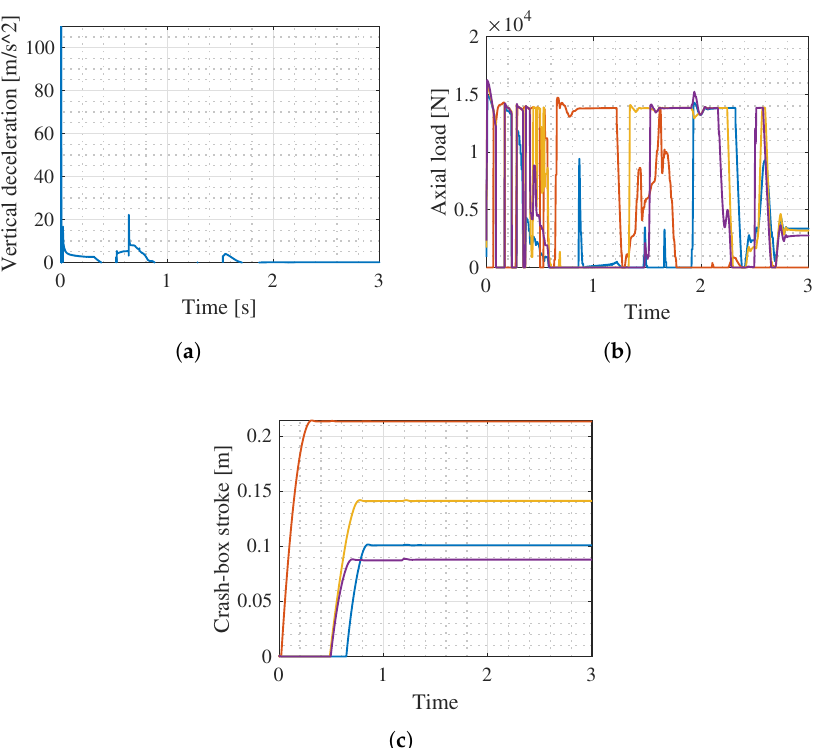
Figure 13. Landing multi-body simulation results for leg 1 (orange), leg 2 (yellow), leg 3 (blue) and leg 4 (violet) according to Figure 12b. ( a ) Vertical acceleration. ( b ) Axial load on primary strut. ( c ) Honeycomb crash box impact stroke.